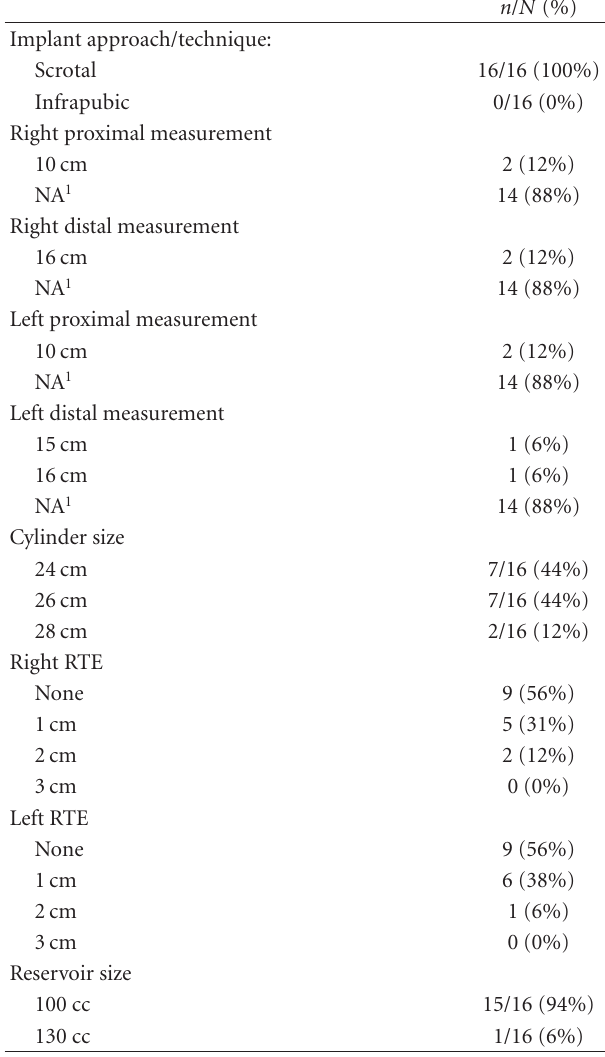
Table 2: General ED etiology and presence of peyronie’s disease. Medical history condition